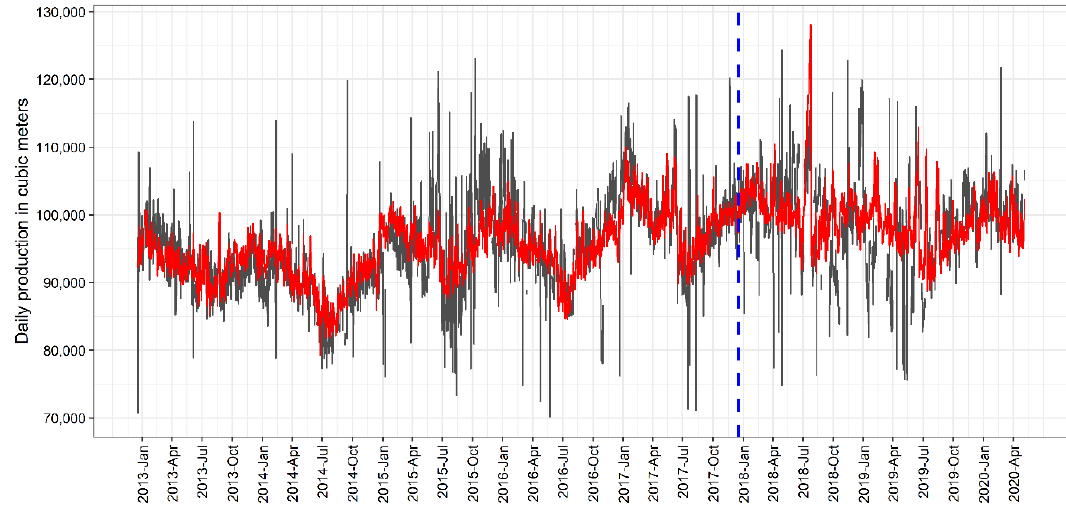
Figure 6. Observed (grey line) daily volume of CILE and fitted (red line) values using the final model for the training set (before the blue dashed line) and the validation set (after the blue dashed line).